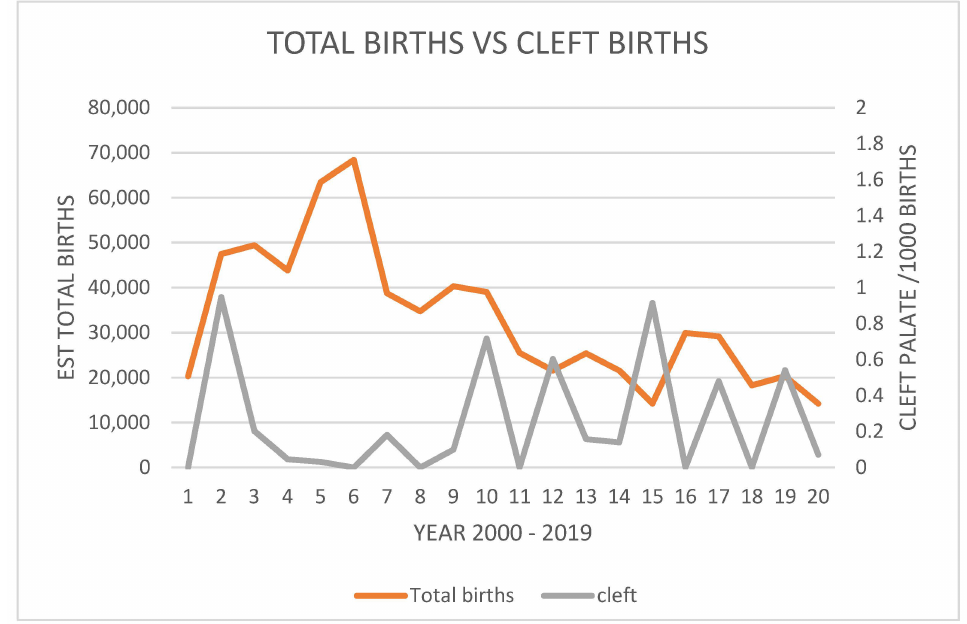
Figure 7. Estimated total births of spectacled flying fox pups versus births of pups with cleft palate